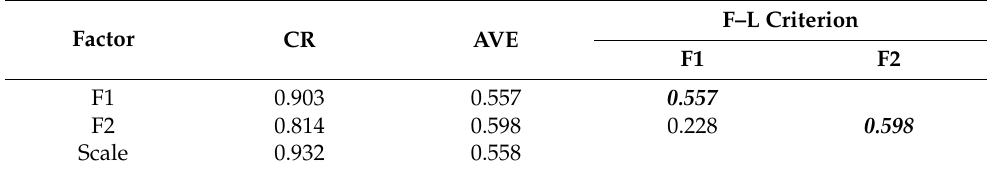
Table 3. Construct validity of the revised Japanese version of the ISS ( N = 294 1